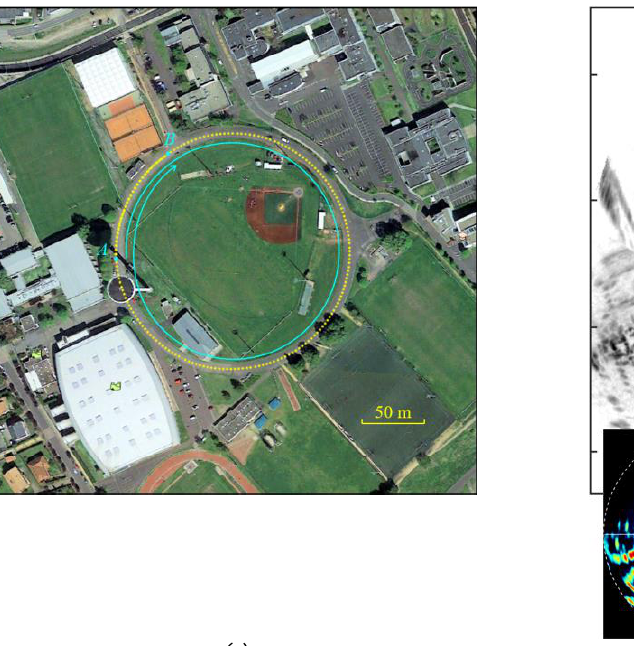
Figure 9. Experimental results. PELICAN radar is positioned on an experimental 4×4 vehicle, 3 m above ground. (a) Aerial image of the test zone. The vehicle follows a circular trajectory around a baseball stadium (covered distance: 685 m; mean velocity: 3 m/s): A and B are starting and end points respectively. Yellow dots indicate GPS trajectory (centimetric precision). (b) 2D radar map used for localization purpose. The red dots indicate the computed radar trajectory. Upper and lower images are examples of radar images used during the 3D matching process in order to determine radar’s position ( x , y ) and orientation θ within the